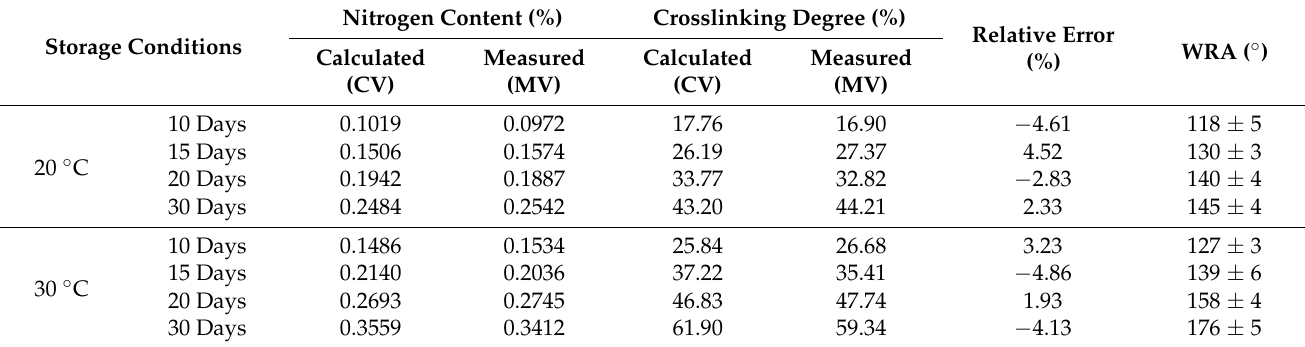
Table 1. Calculated and measured values of nitrogen content after long-term